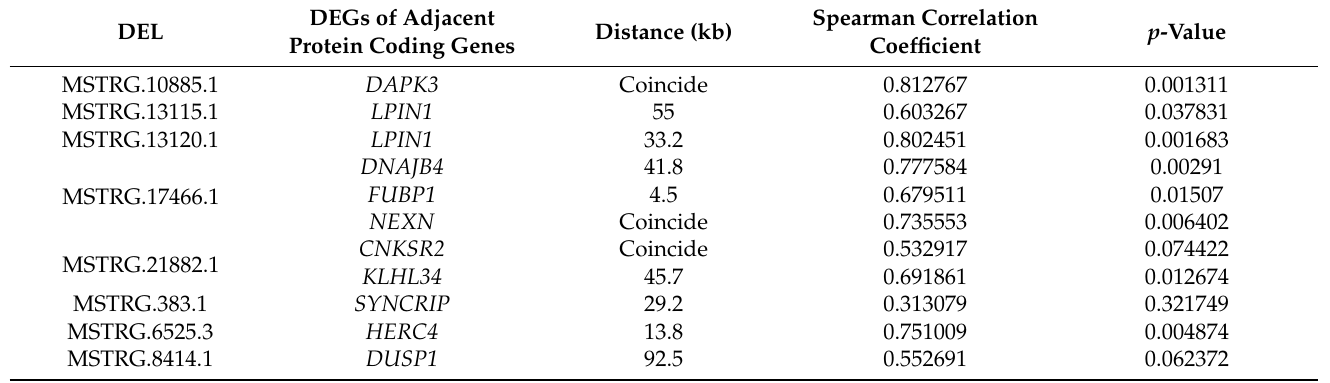
Table 1. The correlation between differentially expressed lncRNAs (DELs) and adjacent coding protein genes in differentially expressed genes